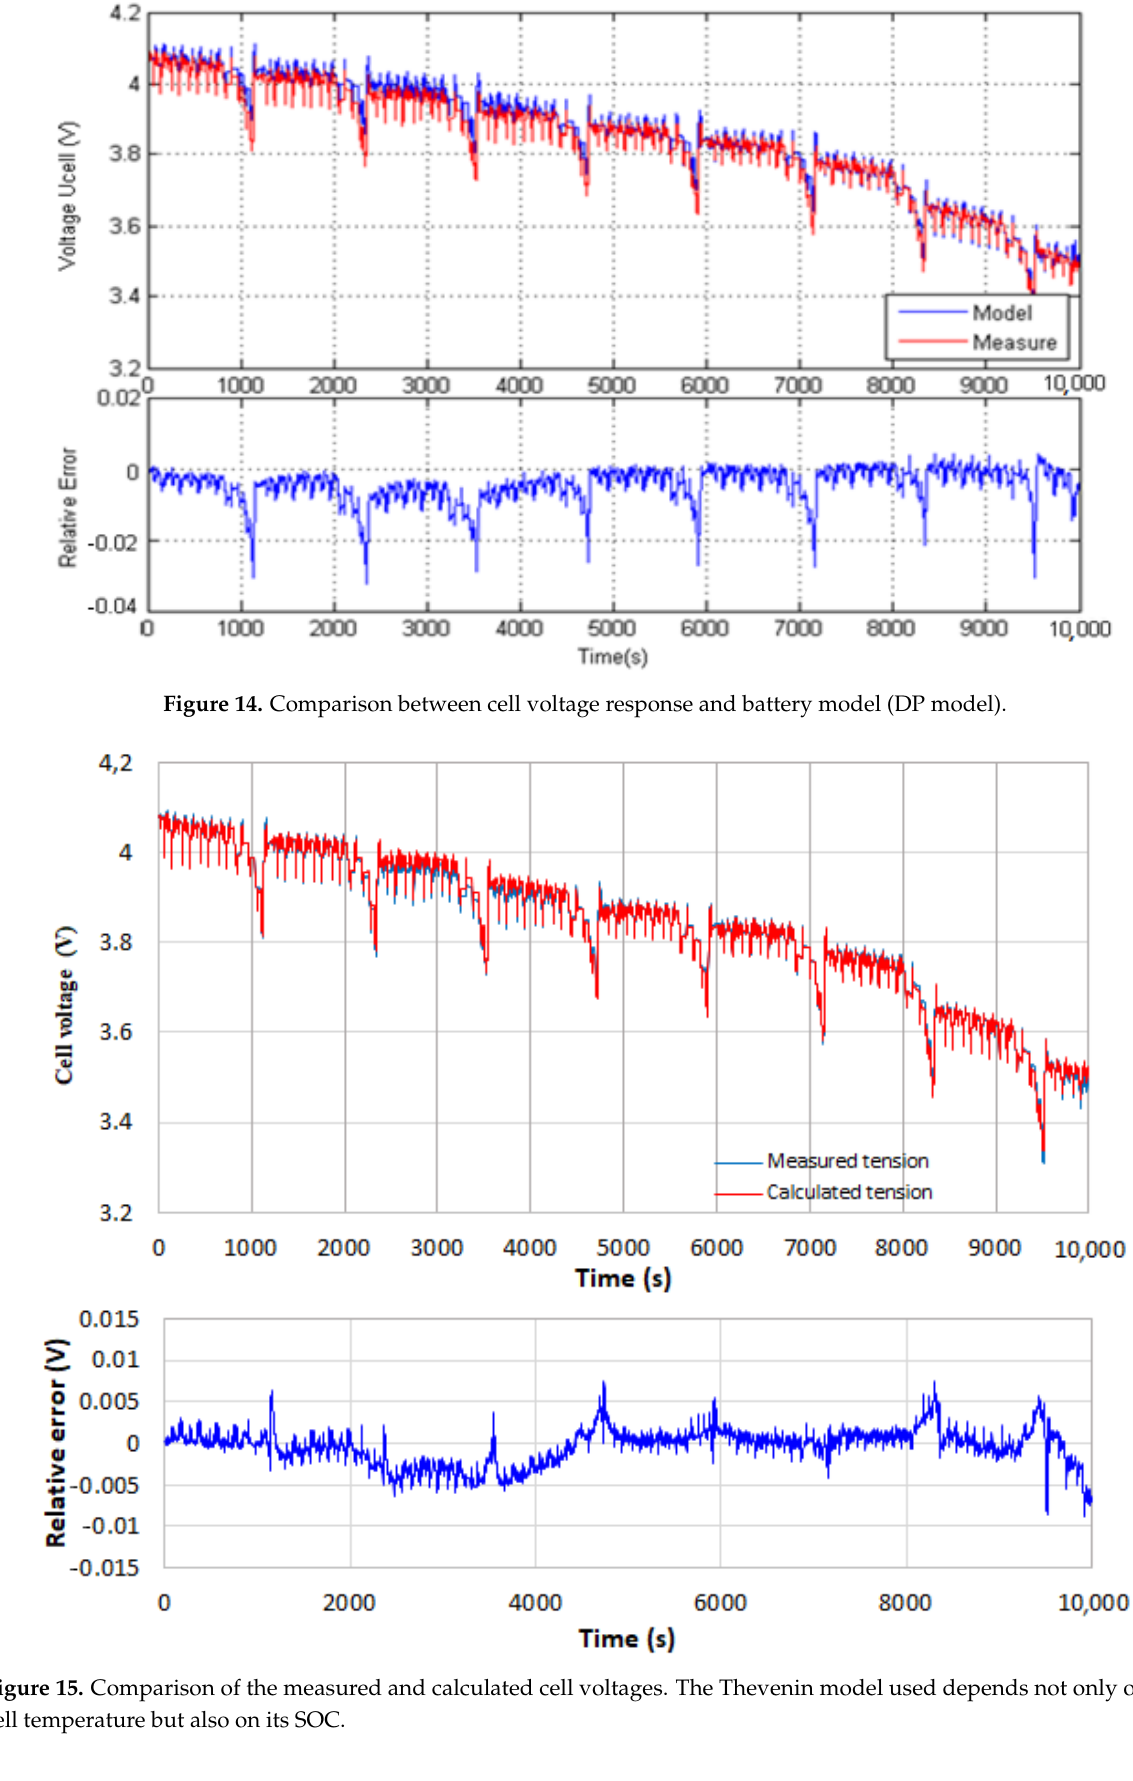
Figure 15. Comparison of the measured and calculated cell voltages. The Thevenin model used depends not only on the cell temperature but also on its SOC.